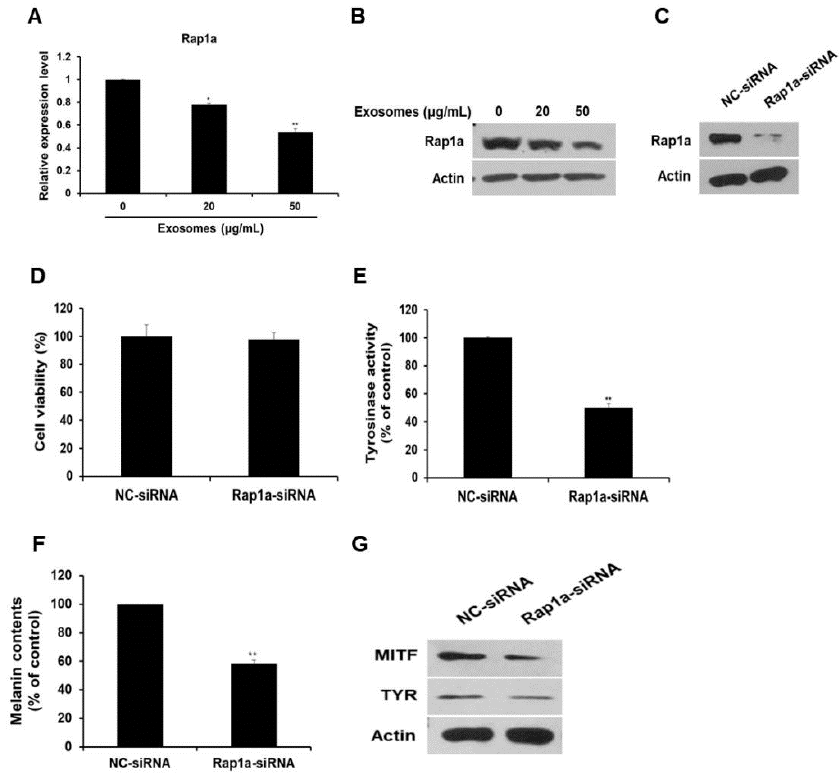
Figure 6. Silencing of Rap1a suppresses melanogenesis. ( A , B ) Levels of Rap1a mRNA and protein in B16F10 cells treated with milk exosomes were examined by qRT-PCR and Western blotting; n = 3, * p < 0.05, ** p < 0.01. ( C ) Levels of Rap1a protein were determined by Western blotting in negative control siRNA (NC-siRNA) or Rap1a siRNA-treated cells. ( D ) B16F10 cells were transfected with NC-siRNA or Rap1a-siRNA. A cell viability assay (WST assay) was performed at 48 h post-transfection. ( E , F ) Tyrosinase activity and melanin contents were assayed in the cells transfected with NC-siRNA or Rap1a-siRNA; n = 3, ** p < 0.01. ( G ) Expression of the proteins MITF and TYR was measured in Rap1a siRNA-treated cells by Western blotting.